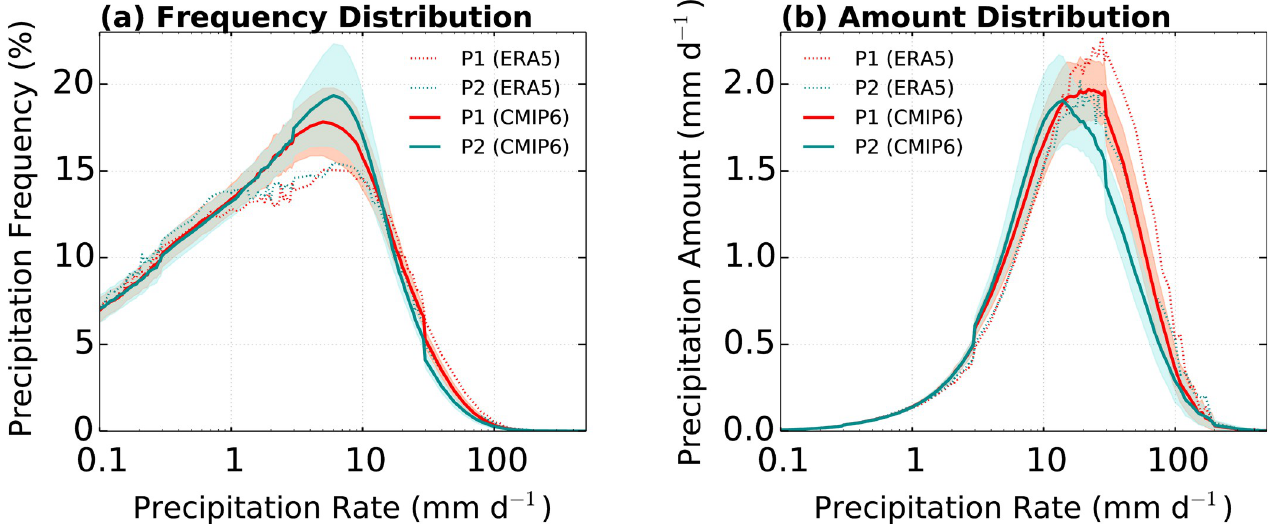
Fig 5. Daily precipitation over the EA domain for distributions of (a) precipitation frequency (%) and (b) precipitation amount (mm d − 1 ) in ERA5 and CMIP6 ensembles. The shading is 95% confidence in the CMIP6 ensemble. Red and blue lines indicate P1 and P2, respectively. Solid and dashed lines indicate CMIP6 and ERA5 ensembles,